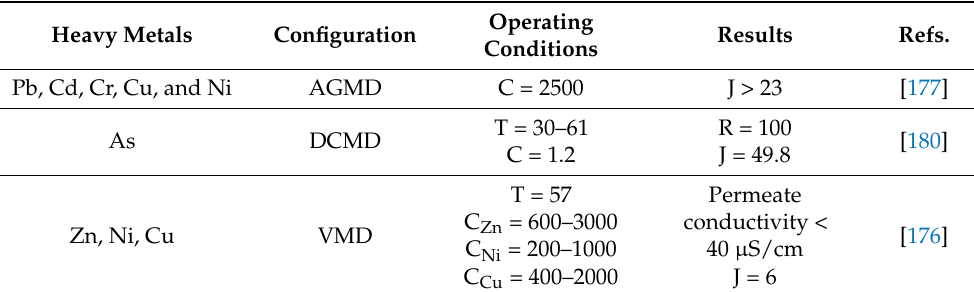
Table 8. MD performances for heavy metal